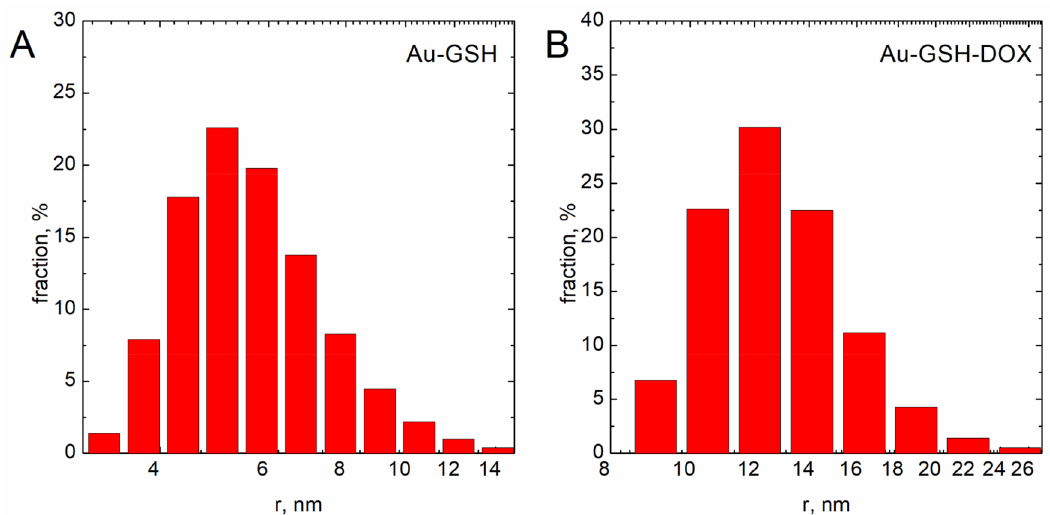
Figure 1. ( A ) Au-GSH size and size distribution. ( B ) Nanoparticle size and size distribution after linking doxorubicin.